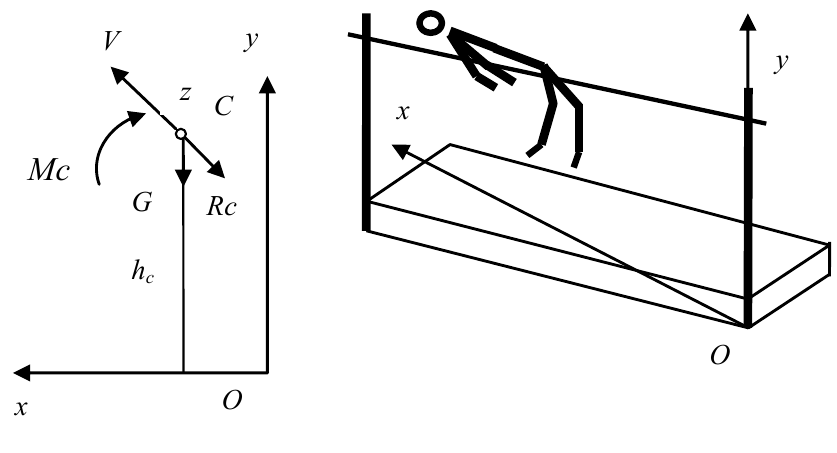
Fig.2. Calculated diagram for determination of rational bio-mechanical parameters in flight